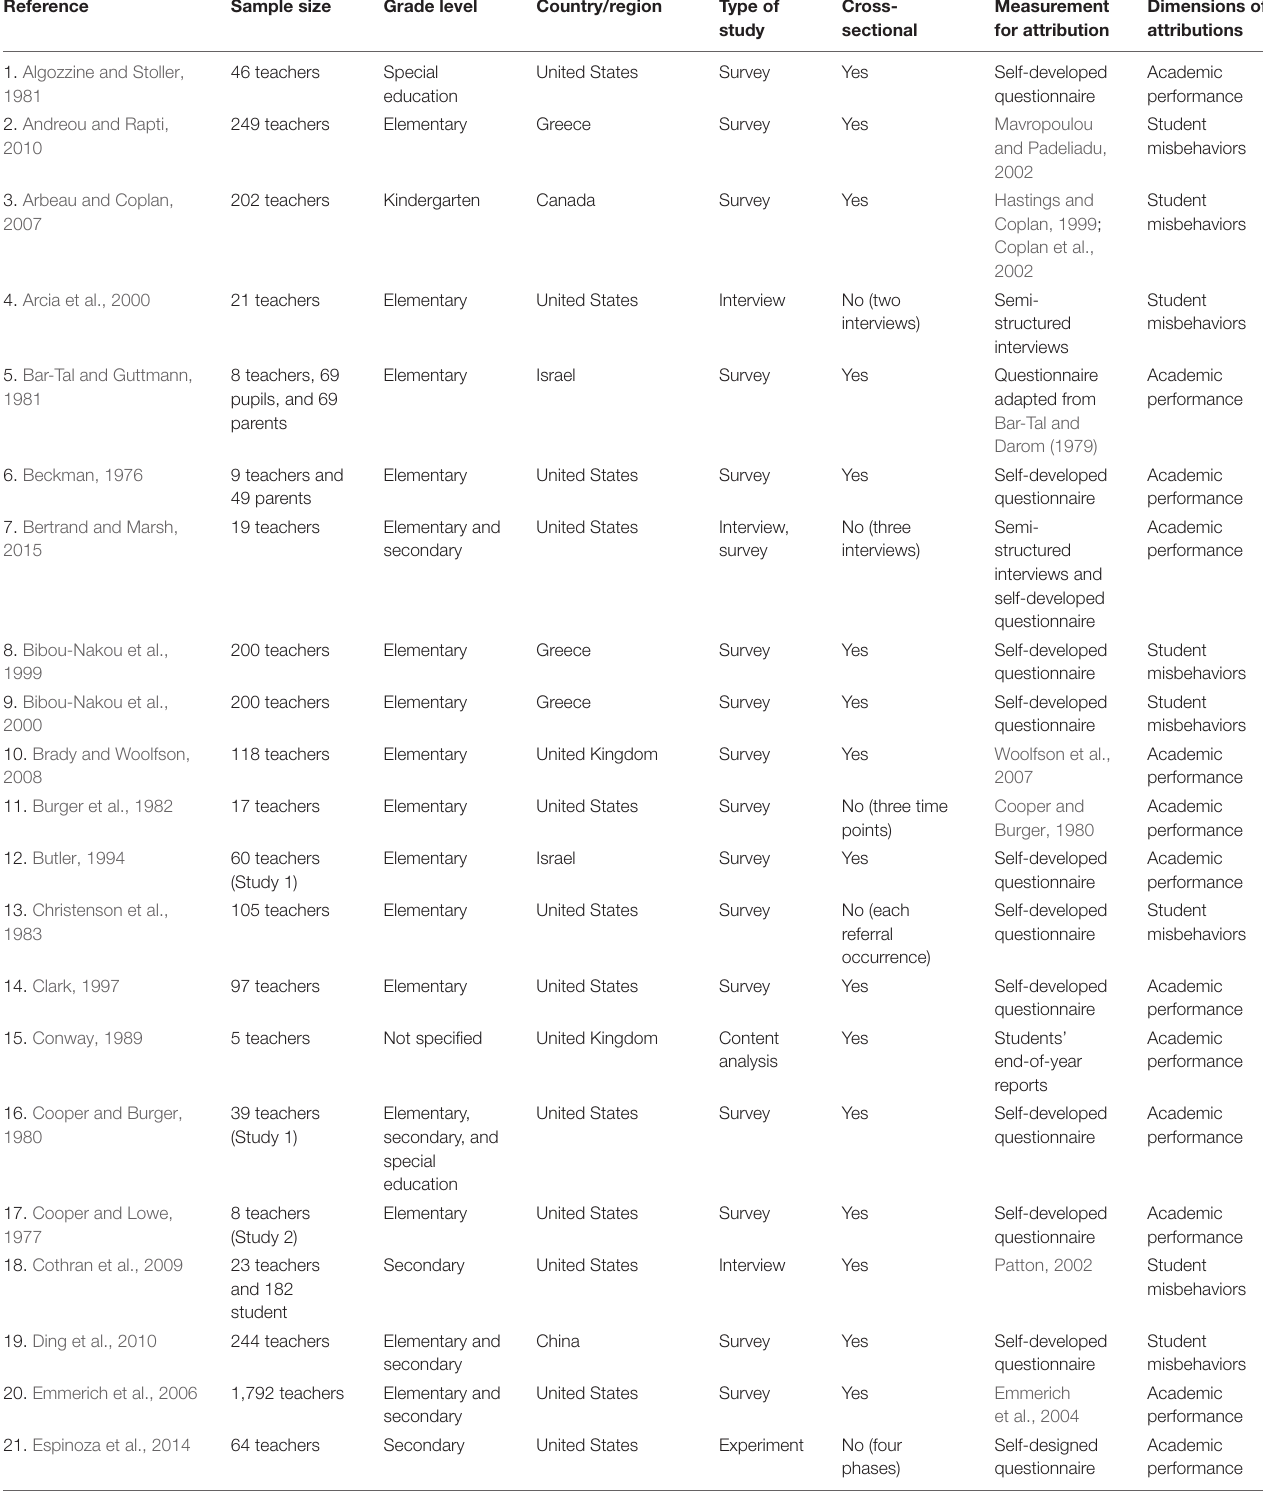
TABLE 2 | Study designs and paradigms for all 79 studies reviewed.